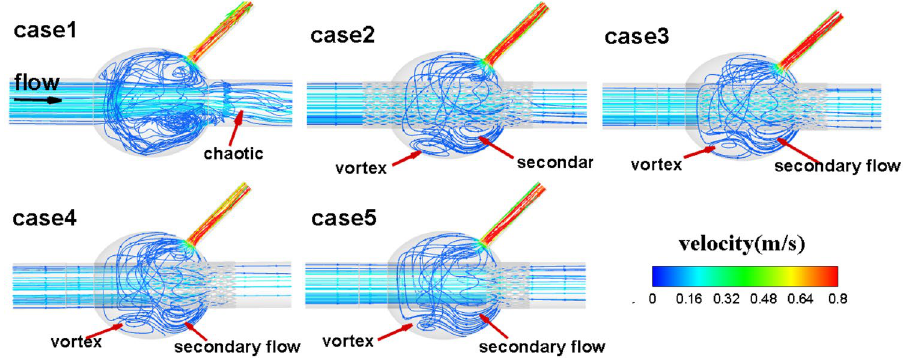
Figure 2. Streamlines in the cases 1–5 models.